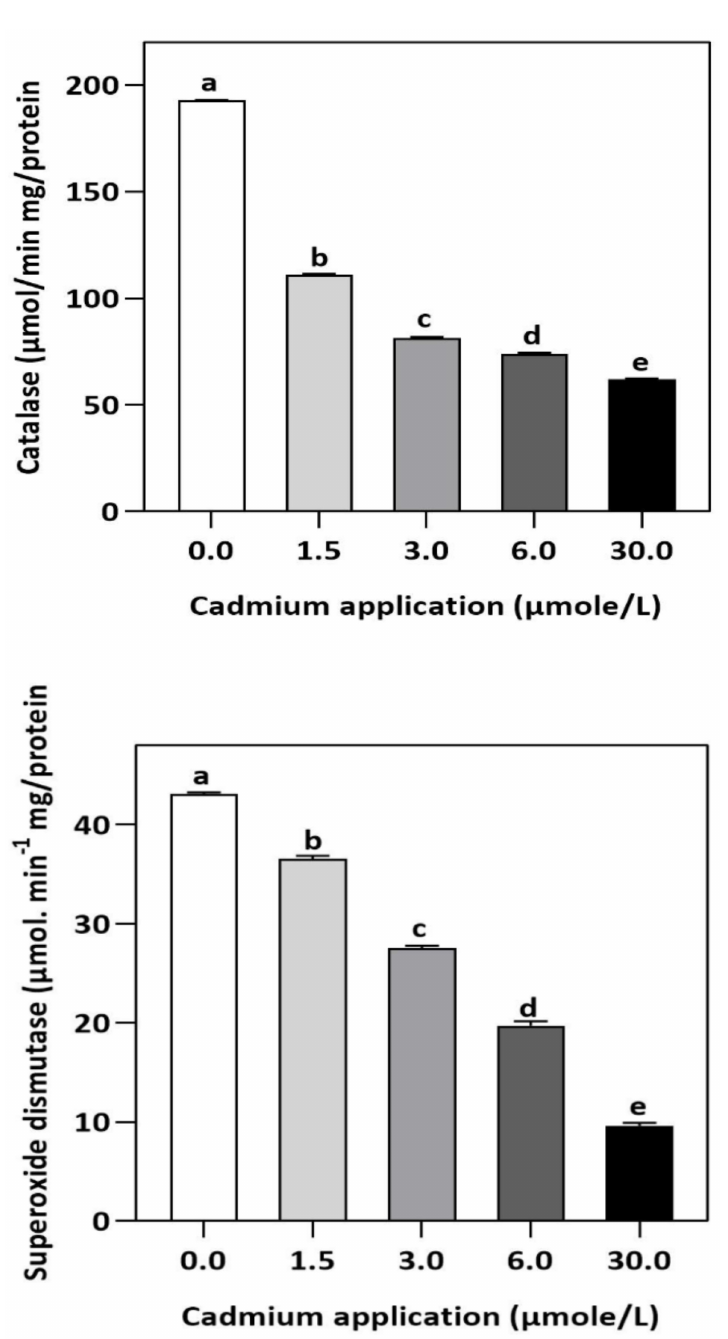
Figure 3. Effect of Cd application on the enzymatic activities of CAT and SOD in E. sativa leaves. Each data value is presented at mean ± SE (n = 5). In Tukey’s multiple range test ( p < 0.05), different letters indicate significant differences in the